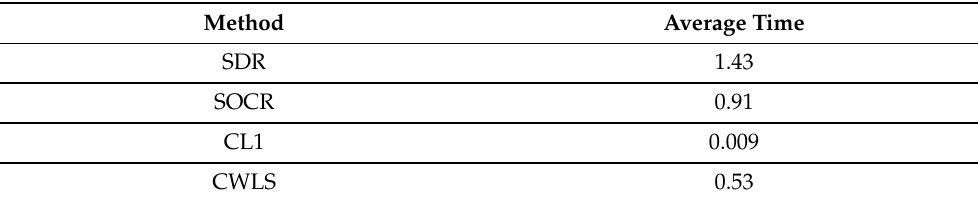
Table 1. Average computation time (in seconds) of four